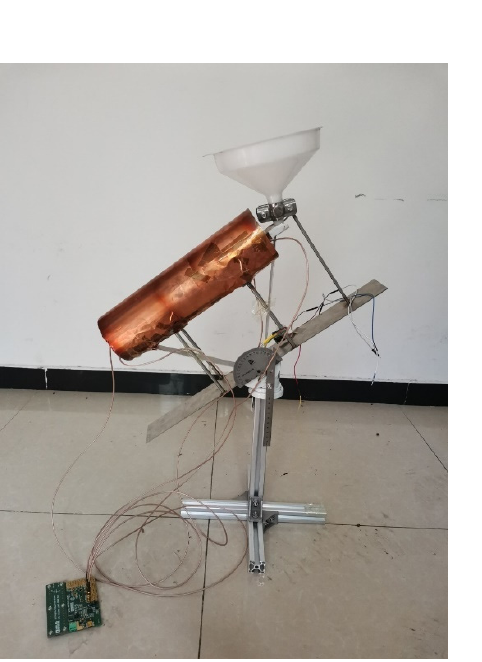
Figure 1. Experimental setup for this research.